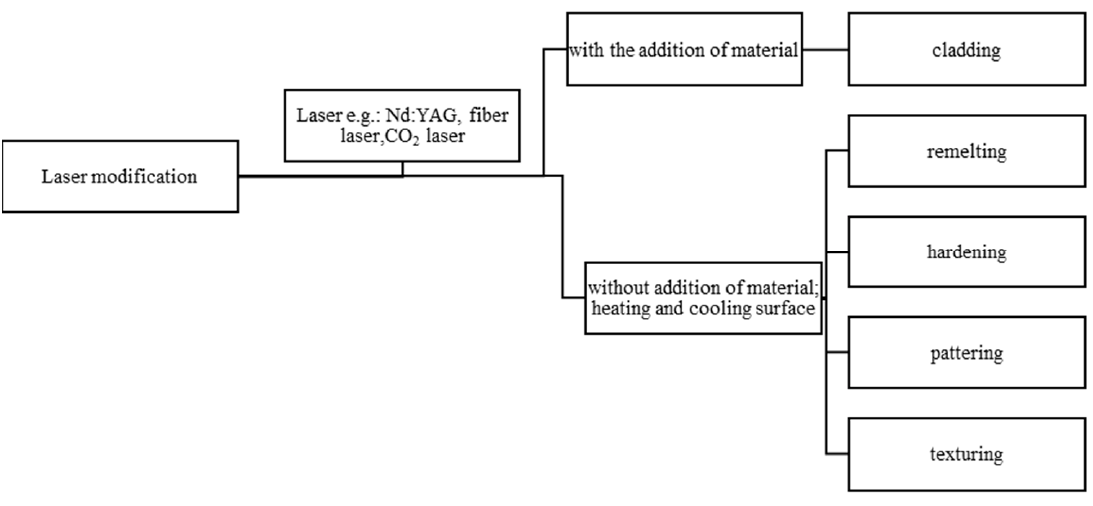
Figure 1. Graphic interpretation of laser modification possibilities based on [1,13,20–22].